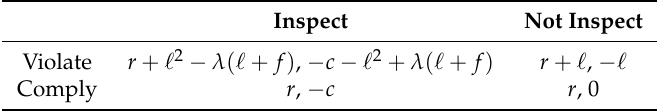
Table 2. Two-player imperfect inspection